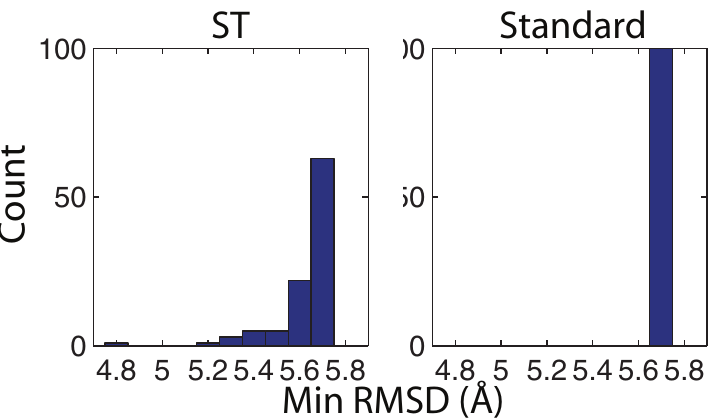
Figure 5. Distribution of the minimum C a RMSD values reached by 100 Simulated Tempering (ST) and 100 standard Rosetta runs started from a 5.7 A˚ structure. Results for both the low temperature and standard Rosetta variants were identical so only a single plot is shown.